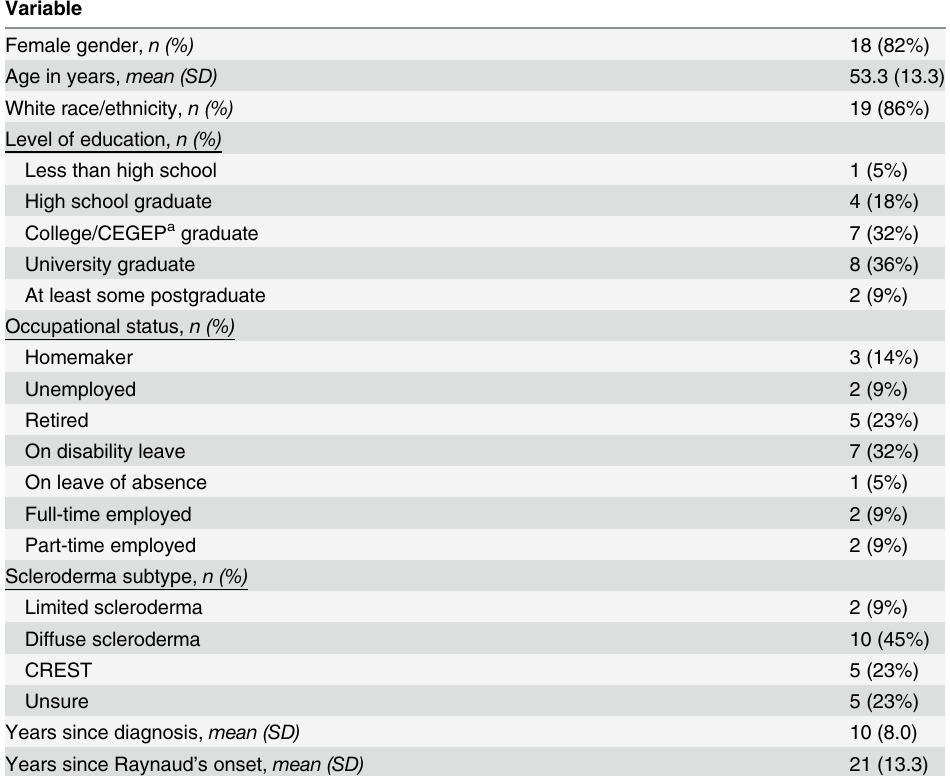
Table 1. Sociodemographic Characteristics of 22 Focus Group